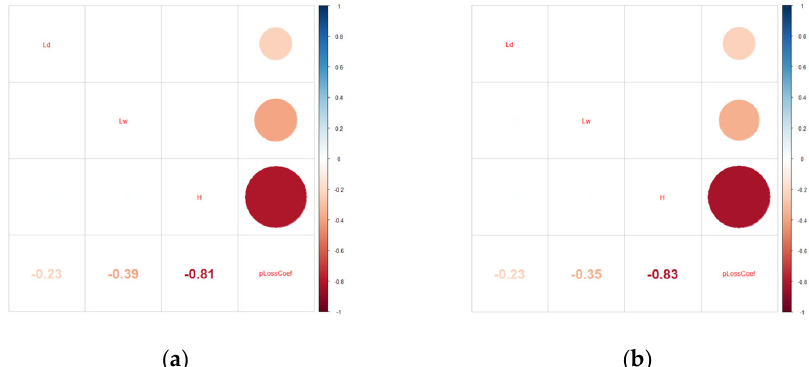
Figure 13. Correlation plot of the data: ( a ) Re = 24,230; ( b ) Re = 77,901.